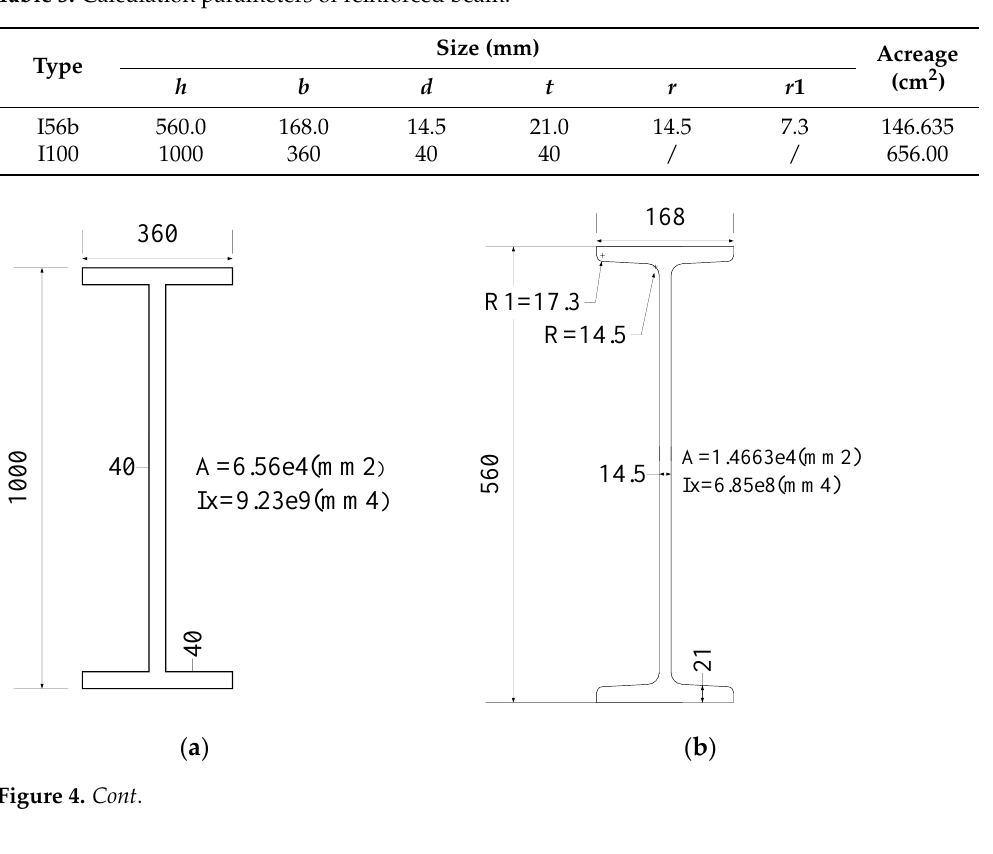
Table 3. Calculation parameters of reinforced beam.